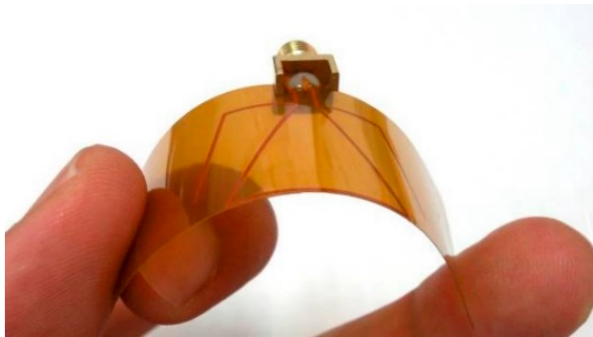
Figure 4. Fabricated prototype of the pattern-reconfigurable antenna on flexible polyimide in [85].